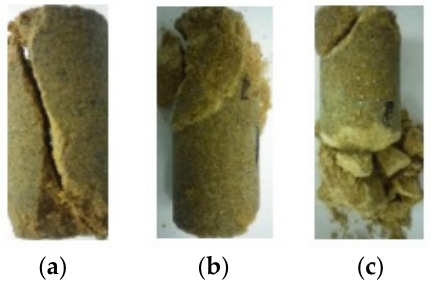
Figure 2. Typical modes of failure of the rock specimens ( a ) Confining pressure 10 MPa, ( b ) Confining pressure 20 MPa, ( c ) Confining pressure 30 MPa [33] Reproduced from [33], Science Press (in Chinese): 2013.